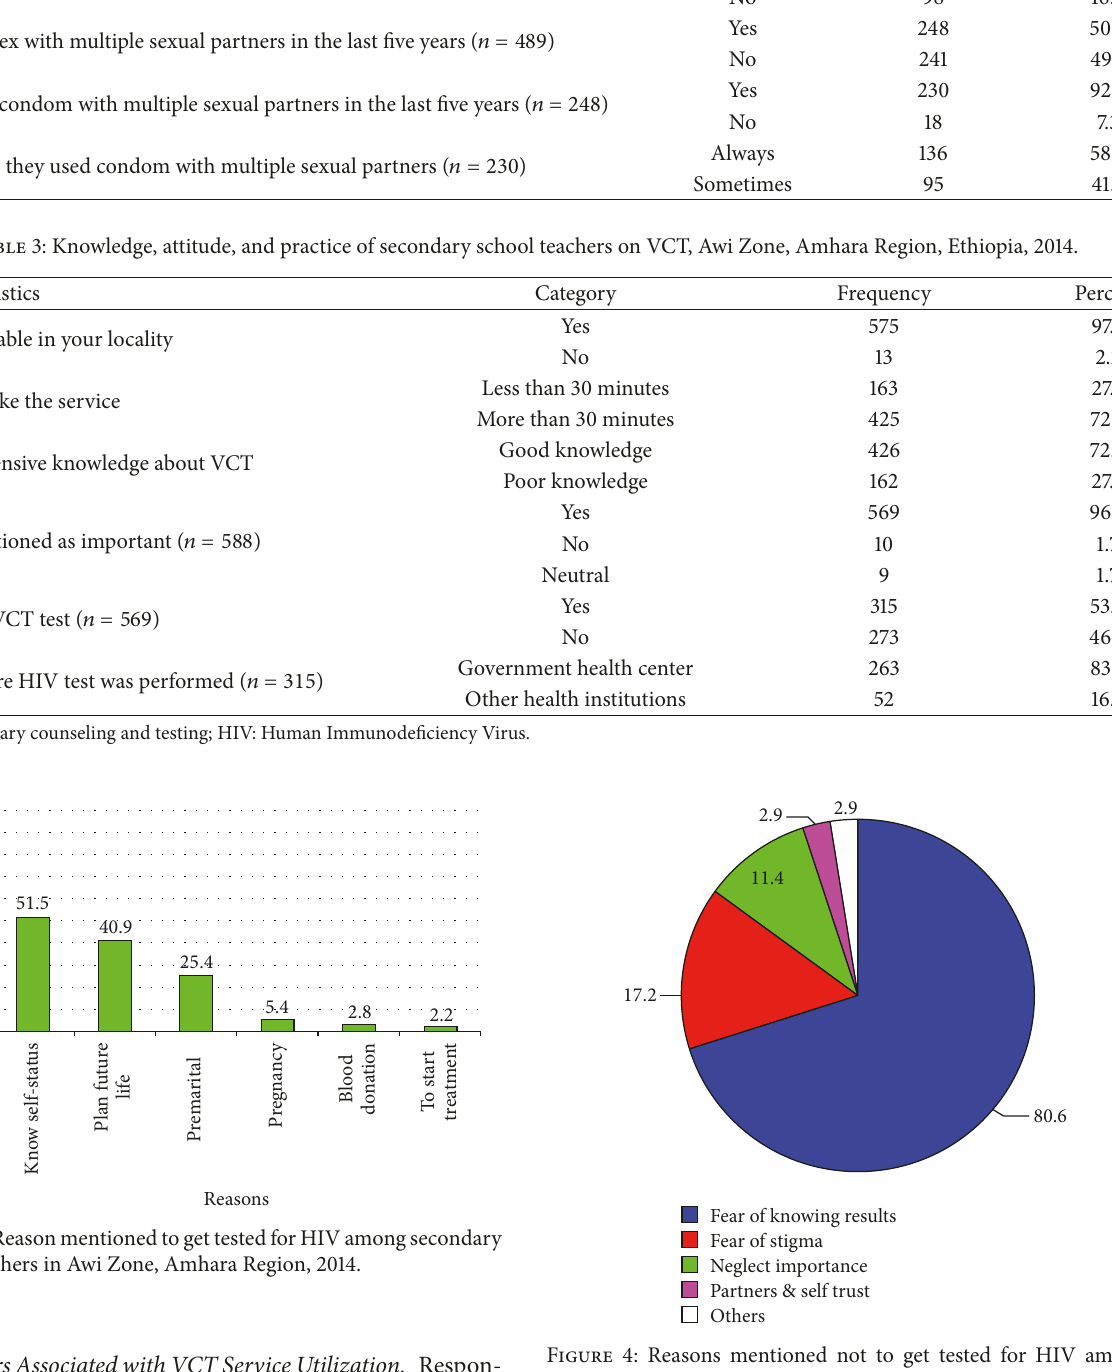
education level of respondents who had first degree and